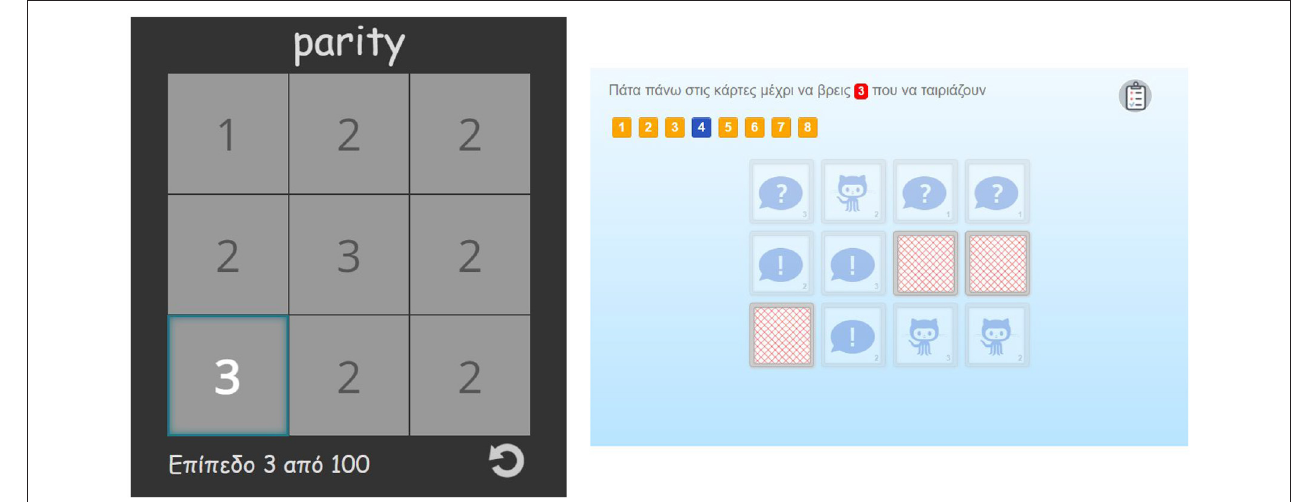
FIGURE 4 | Examples of game activities in